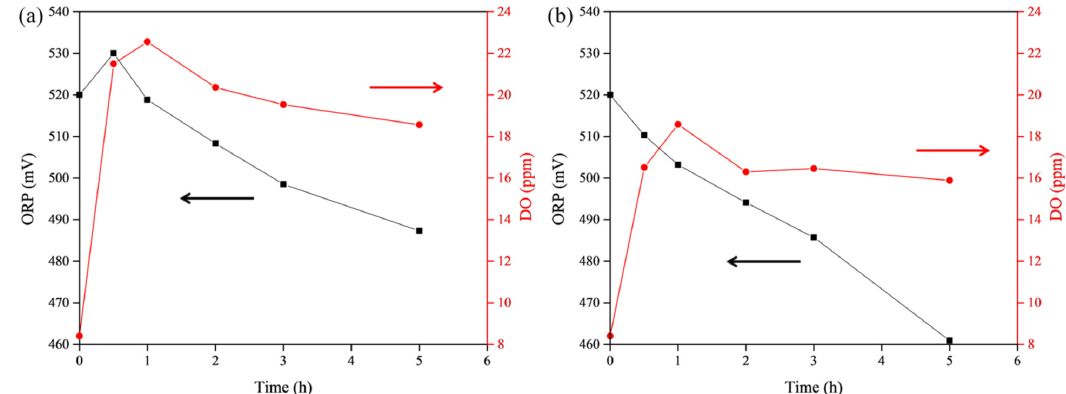
Figure 9. Oxidation / reduction potential (ORP) and dissolved oxygen (DO) concentration versus leaching time ( a ) without and ( b ) with ultrasound assistance at 20% power amplitude (leaching conditions: 1% S / L, 0.5 M acid concentration, 50 ◦ C, and 800 rpm stirring